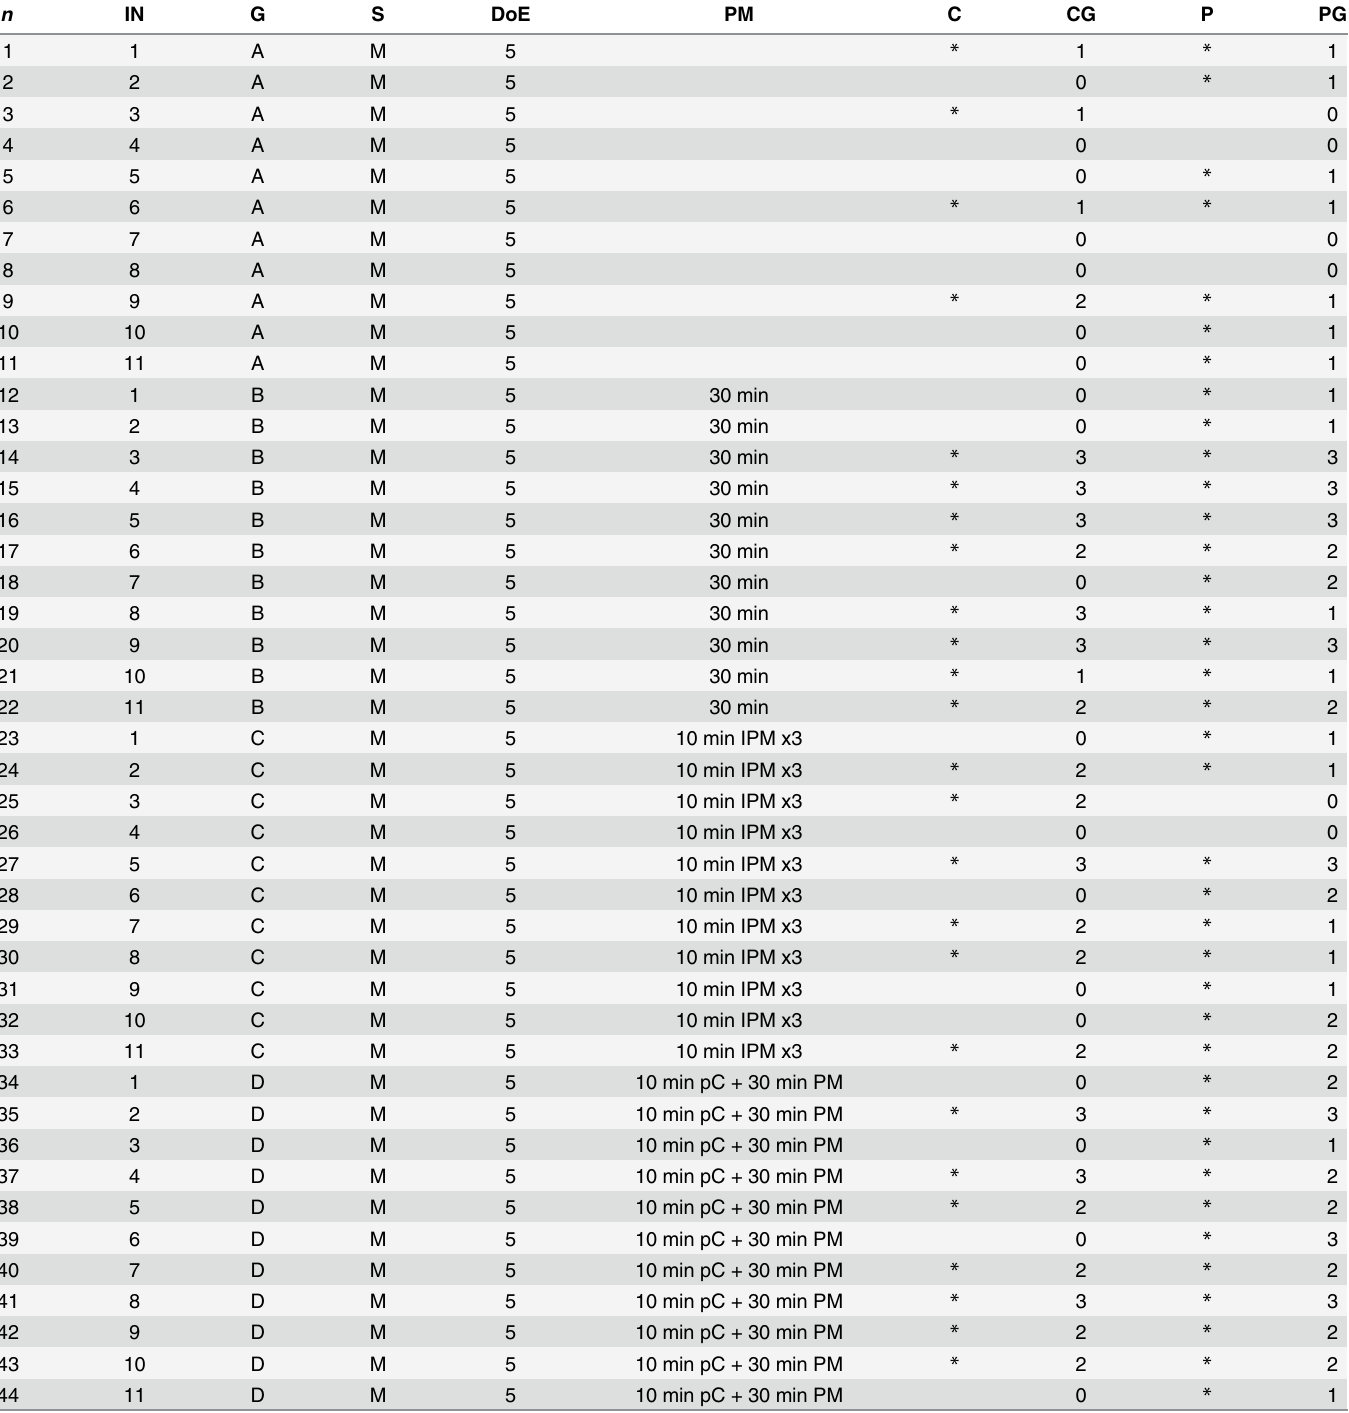
Table 1. Parameters of the